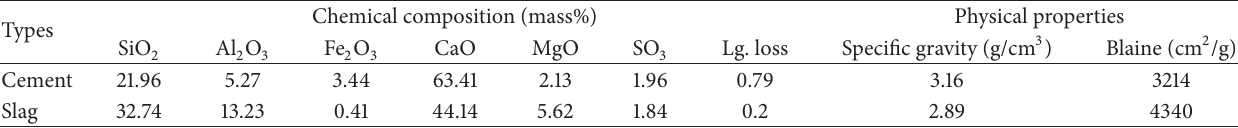
Table 1: Properties of binders [15].